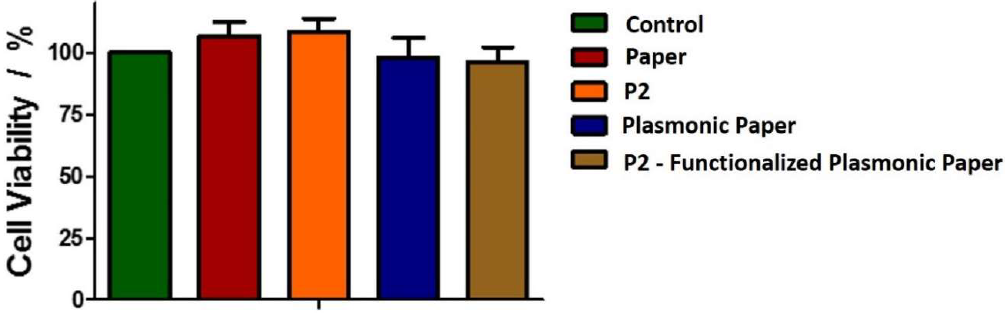
Figure 4. Biocompatibility of the new nanoplatforms against human BJ cells.